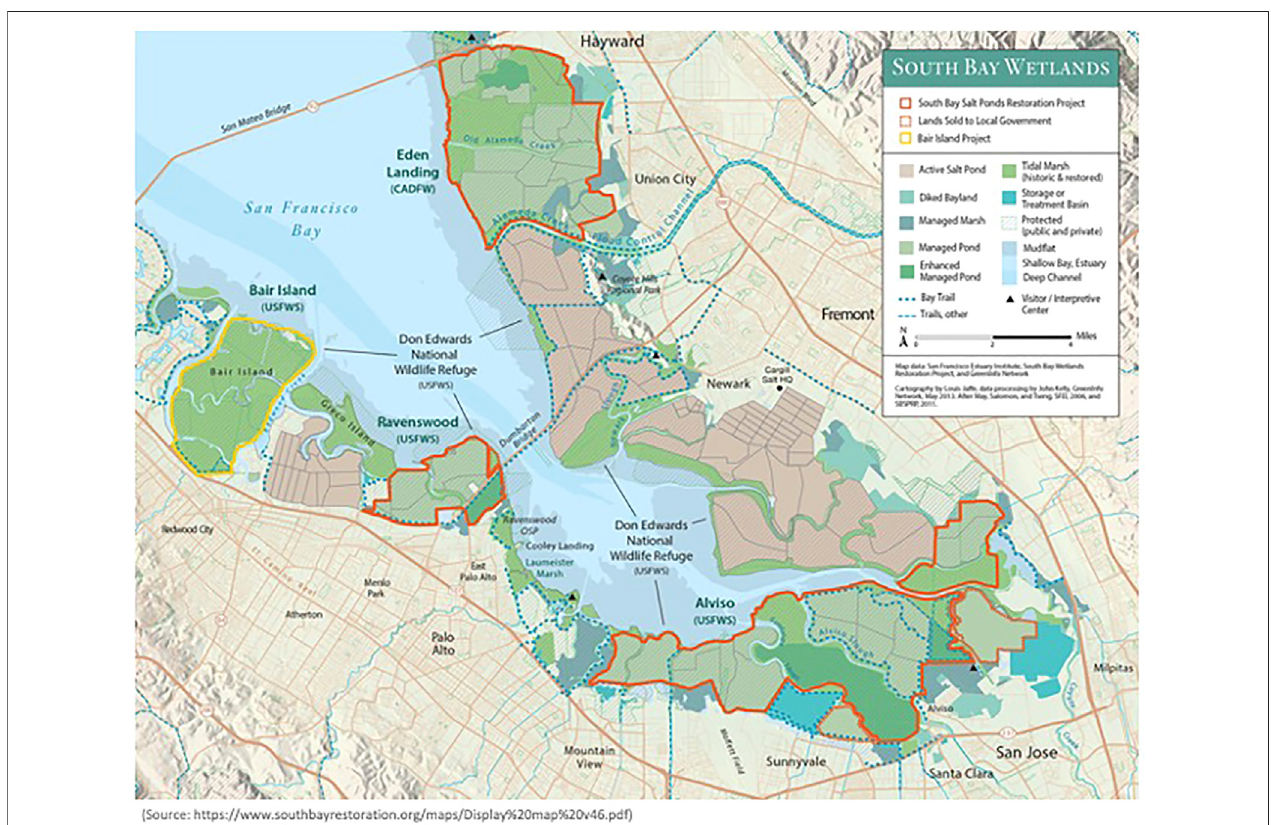
FIGURE 4 | Map of the South Bay Salt Pond Restoration Project in San Francisco Bay.